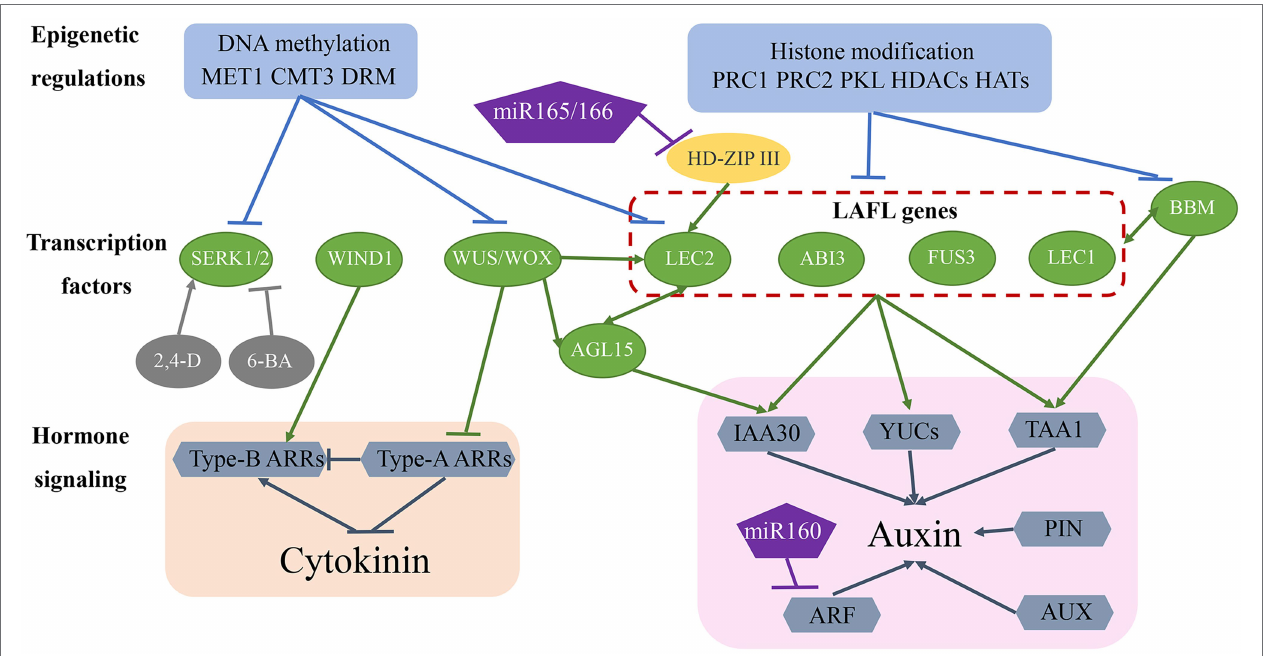
FIGURE 2 | Molecular mechanisms of somatic embryogenesis. The somatic embryogenesis process is influenced by epigenetic regulation, transcription factors, and hormone signalling pathways. Epigenetic regulation, including DNA methylation and histone modifications, repress transcription factor access to gene-promoter regions, thereby inhibiting the expression of genes involved in somatic embryogenesis. Many transcription factors (green ovals) are involved in this regulatory network and also regulate each other and activate downstream auxin and CK signalling pathways. Additionally, miR-160 and miR-165/-166 are involved in regulating somatic